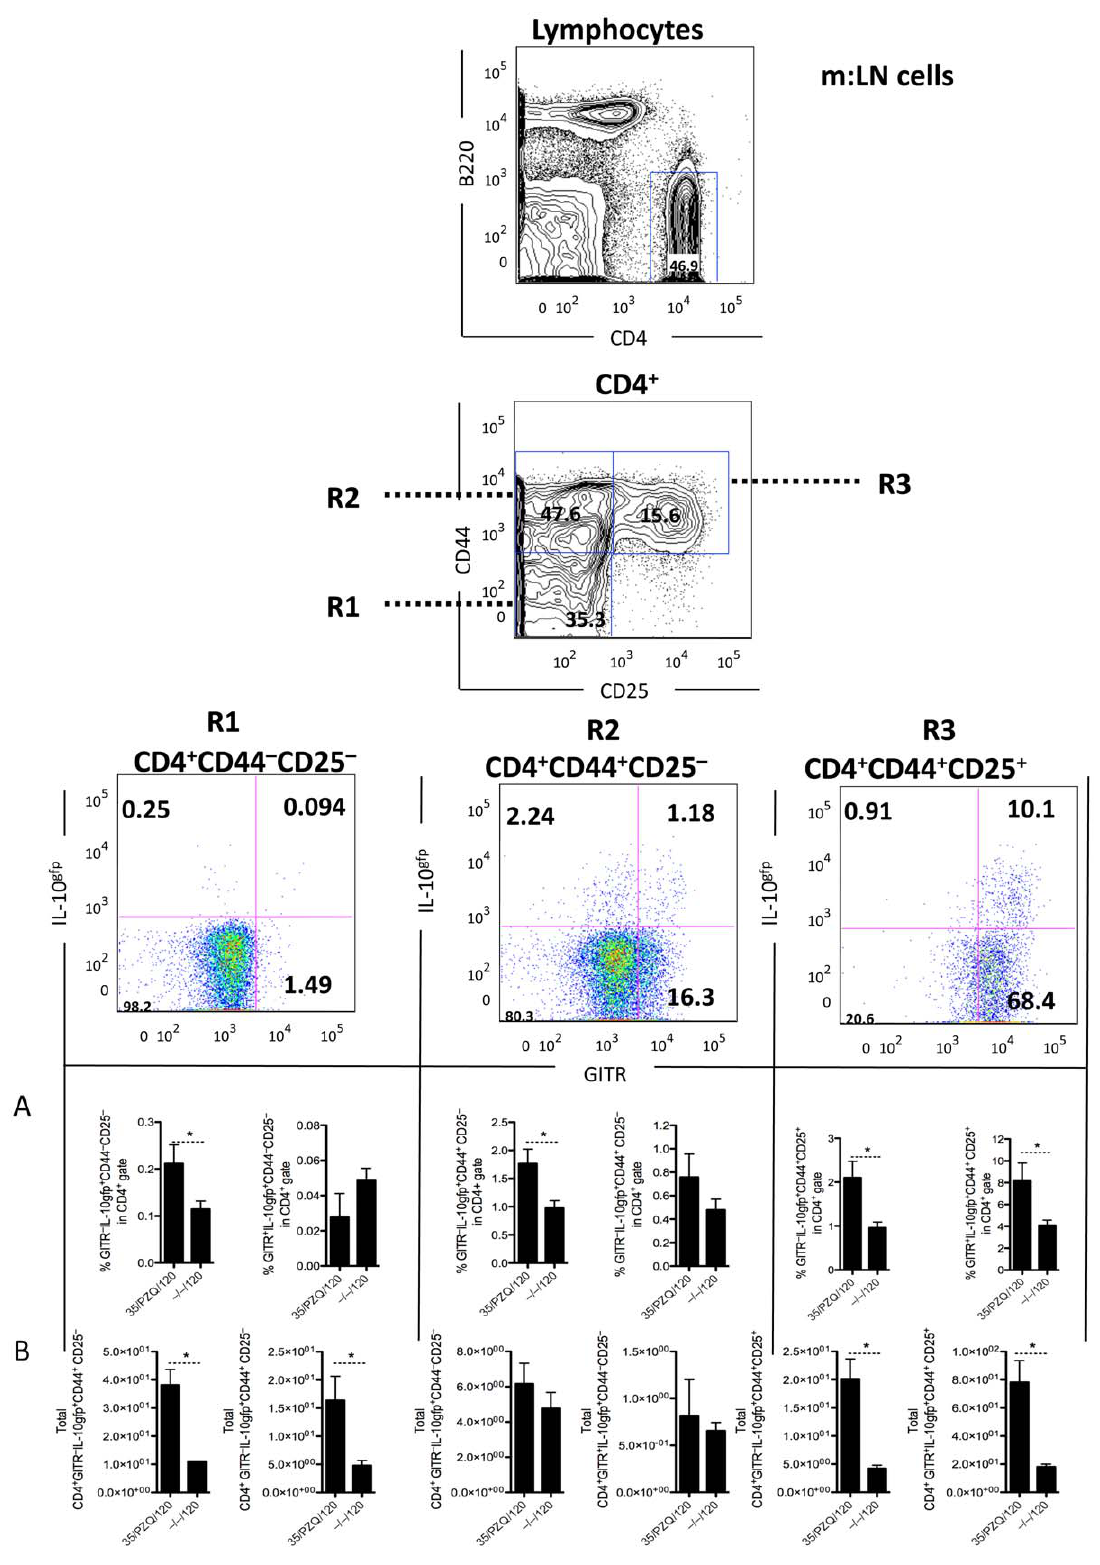
Figure 3. Elevated CD4 + CD44 + CD25 + GITR + IL-10gfp + cells in PZQ-treated mice. C57BL/6 mice were infected as in Figure 2, with cells isolated from the mesenteric lymph nodes at necropsy. Cells were stained, as in methods and analyzed with FlowJo software. Data shown are mean 6 SEM from one of 2 experiments, with 5 mice per group. (A) % of cells in CD4 gate. (B) Total number of cells in mesenteric lymph nodes (x10 3 ).